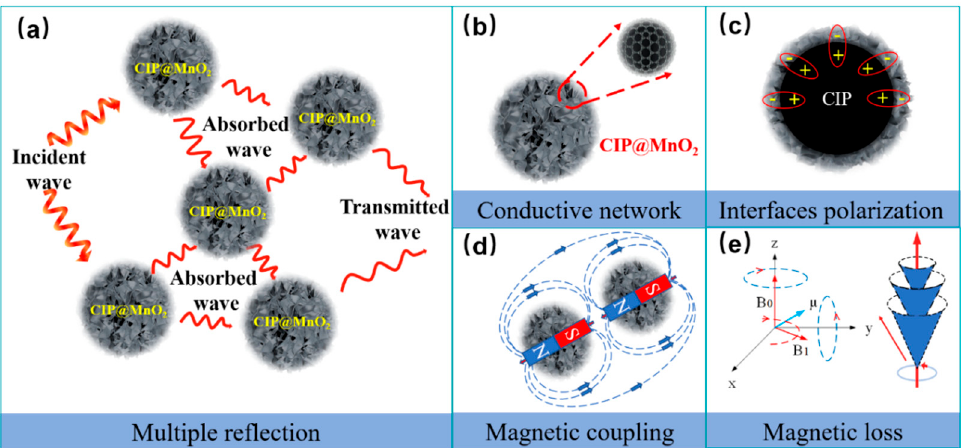
Figure 10. Wave absorption mechanism of CIP@MnO 2 composites with a spherical flower-like structure: multiple reflection ( a ), conduction network ( b ), interfacial polarization ( c ), magnetic coupling ( d ), and magnetic loss ( e ).